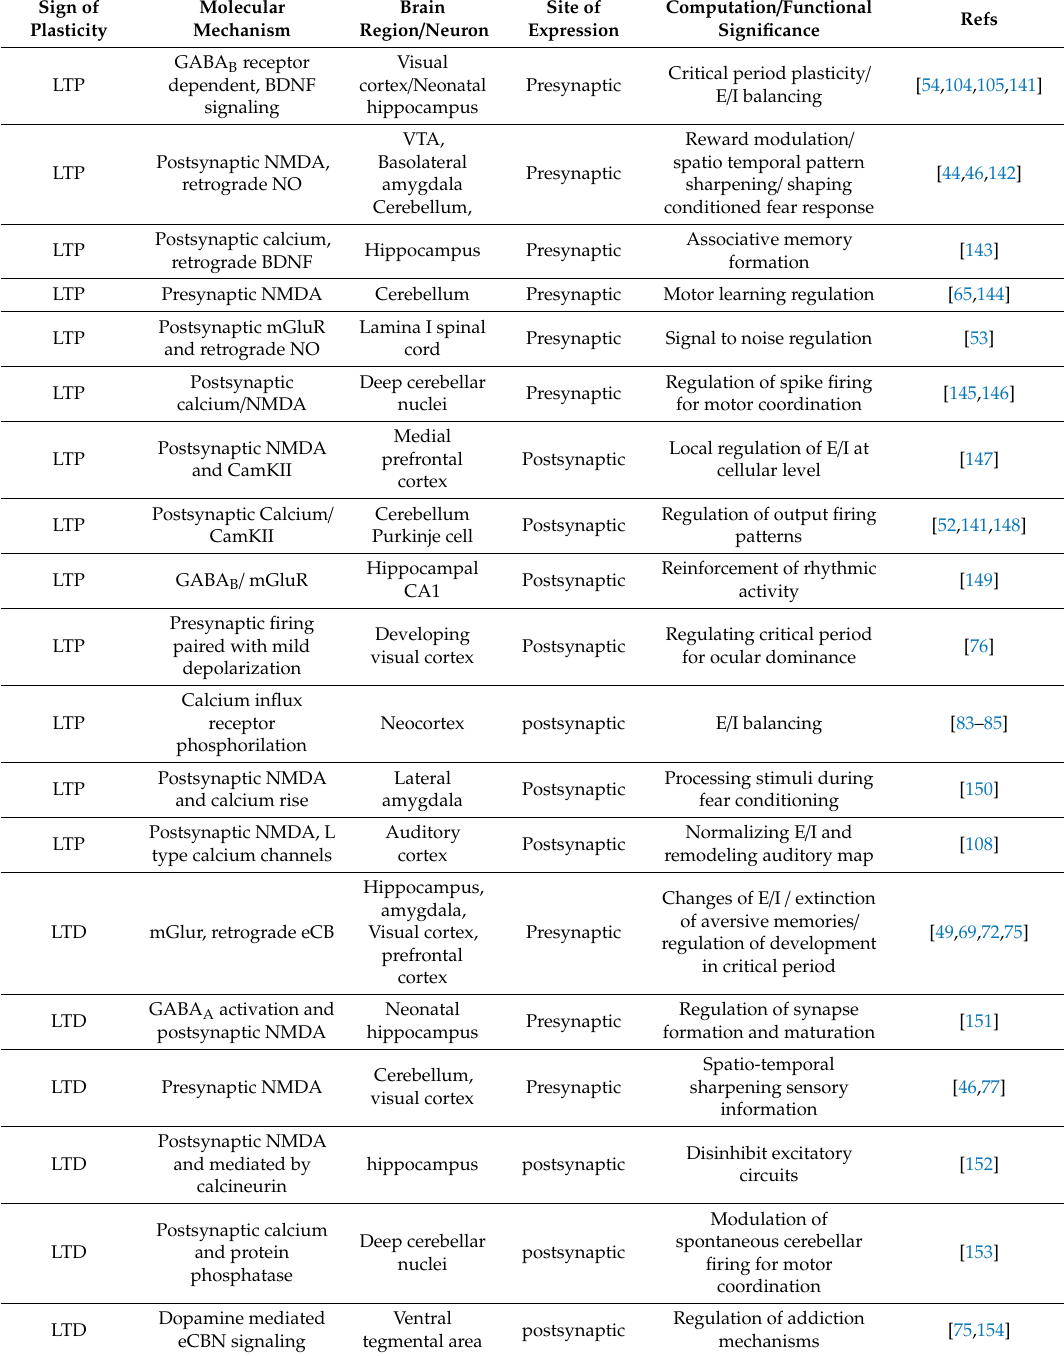
Table 1. Mechanisms of inhibitory plasticity and functional